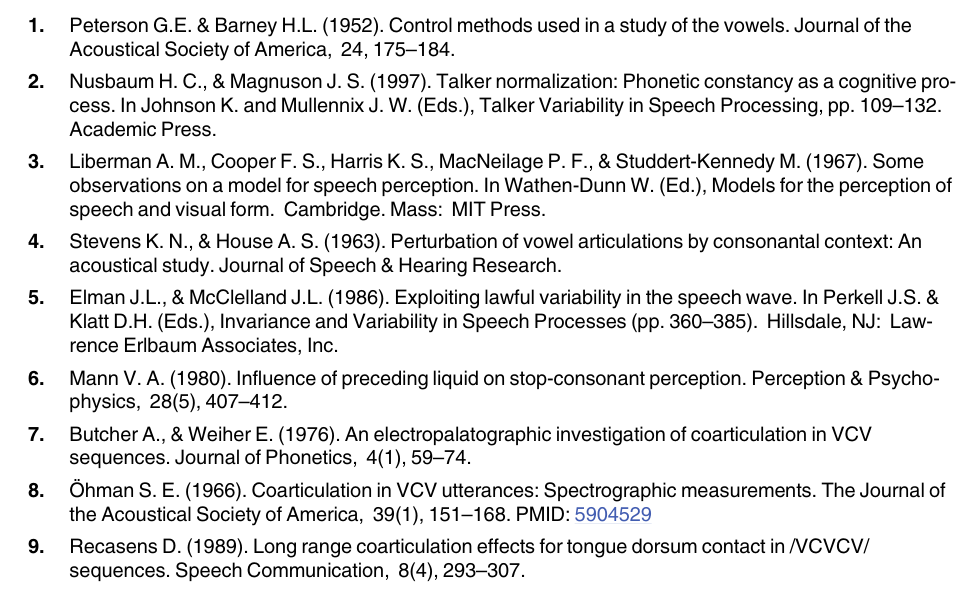
S5 Table. Average Standard Deviation in F0 (in Hz) for each vowel tested at each of the time points for each subject. S6 Table. Average Standard Deviation in F1 (in Hz) for each vowel tested at each of the time points for each subject. S7 Table. Average Standard Deviation in F2 (in Hz) for each vowel tested at each of the time points for each subject. S8 Table. Average Standard Deviation in F3 (in Hz) for each vowel tested at each of the time points for each subject. S9 Table. Average duration (in ms) for each vowel tested at each of the time points for